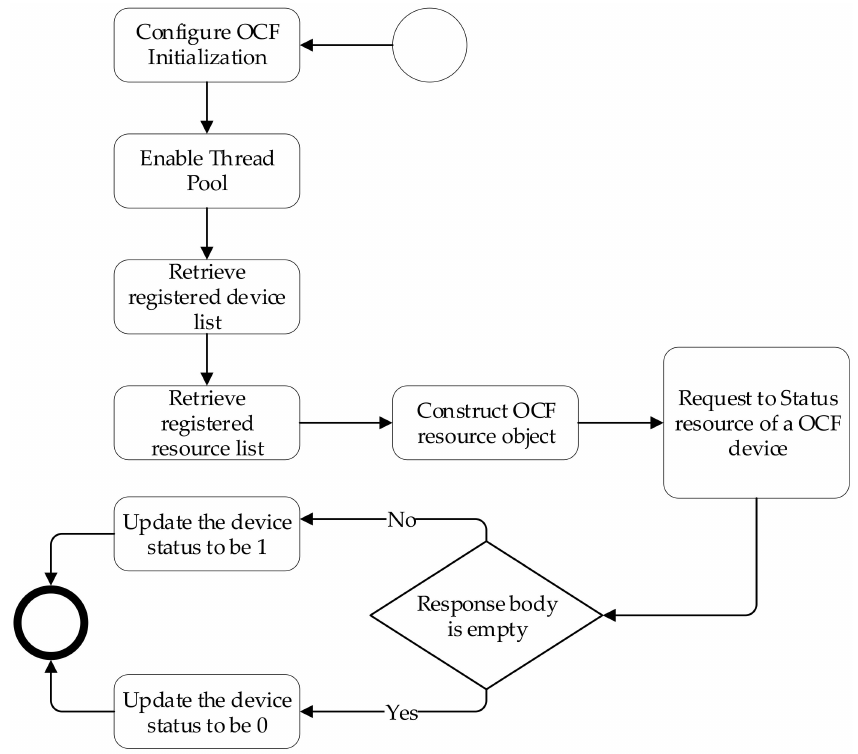
Figure 10. Status detection based on real-time IoT resource